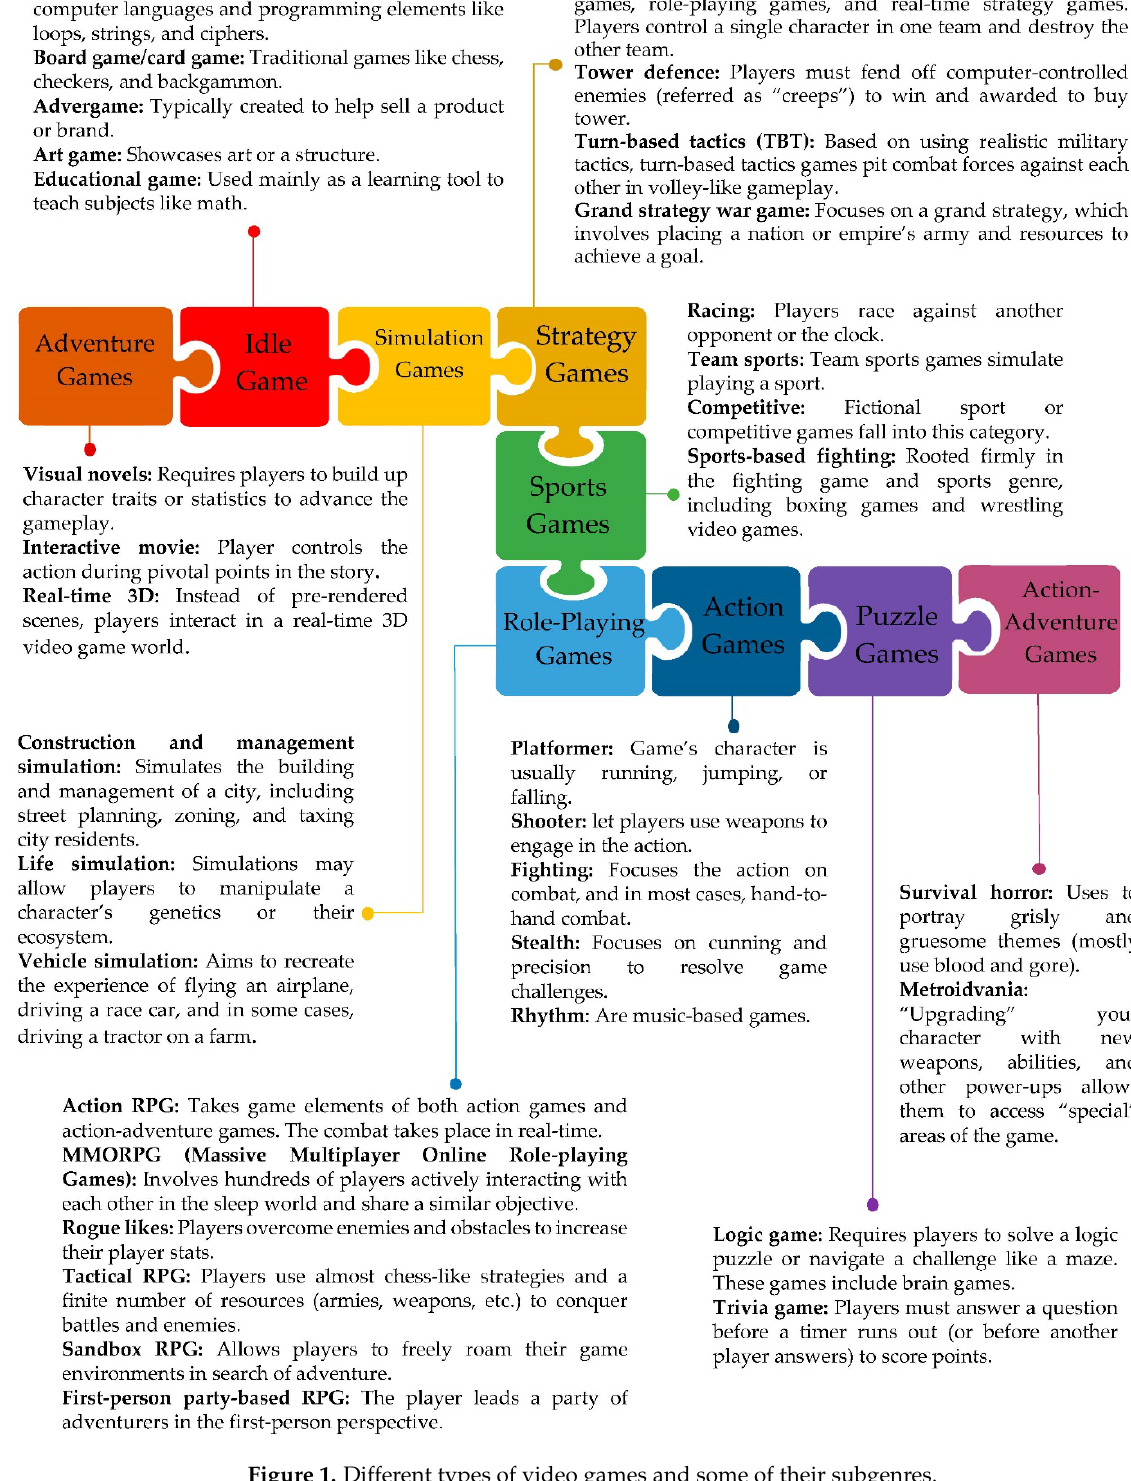
Figure 1. Different types of video games and some of their subgenres.